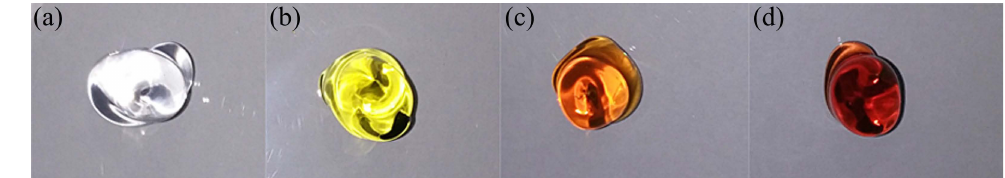
Figure 4. AgNPs containing formulation (AgNPs gels). ( a ) Control gel (without AgNPs), ( b ) AgNPs gels of S1, ( c ) S2 and ( d ) S3.